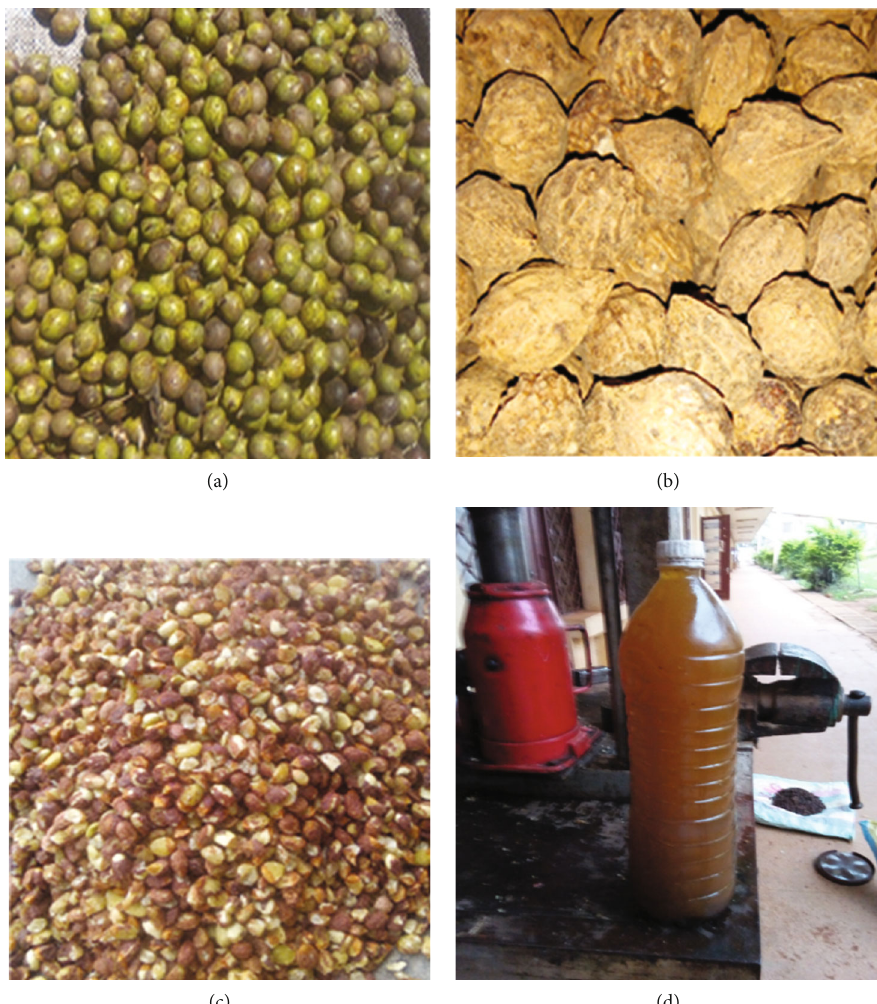
Figure 2: Di ff erent forms of Podocarpus falcatus fruit and Podocarpus oil: (a) fresh fruits; (b) seeds before peeling; (c) seeds after peeling; (d) P. falcatus